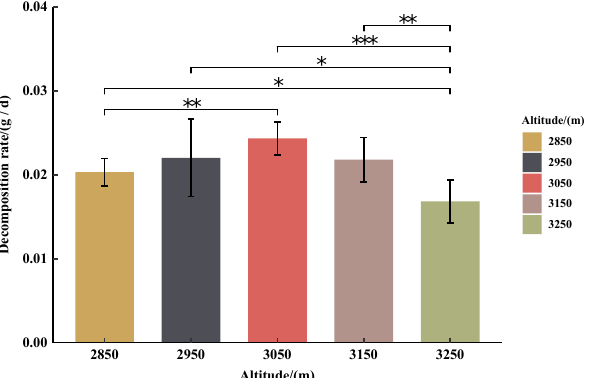
Figure 5. Initial decomposition rate (g·day − 1 ) of Qinghai spruce leaf litter at different altitudes in the growing season. Notes: Values are from bulk litter of each site. n = 30. *, p < 0.05; **, p < 0.01; ***, p < 0.001.